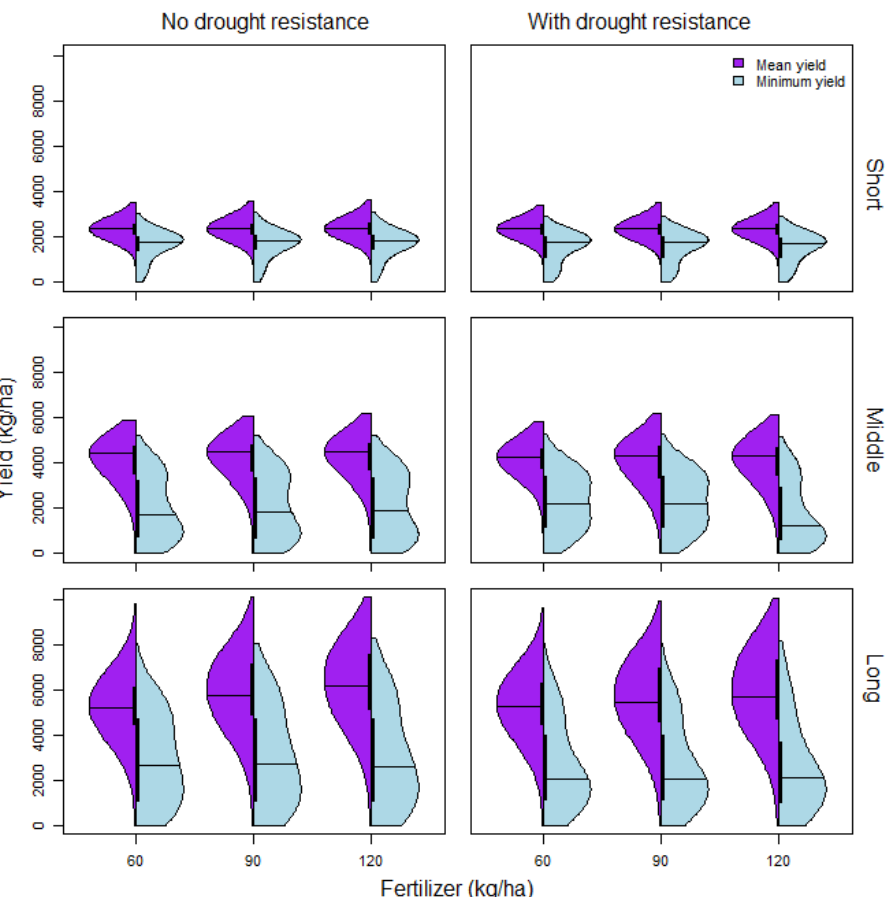
Figure 7. Distribution of mean and minimum yields over the 30 years for all simulation grids and management strategies.